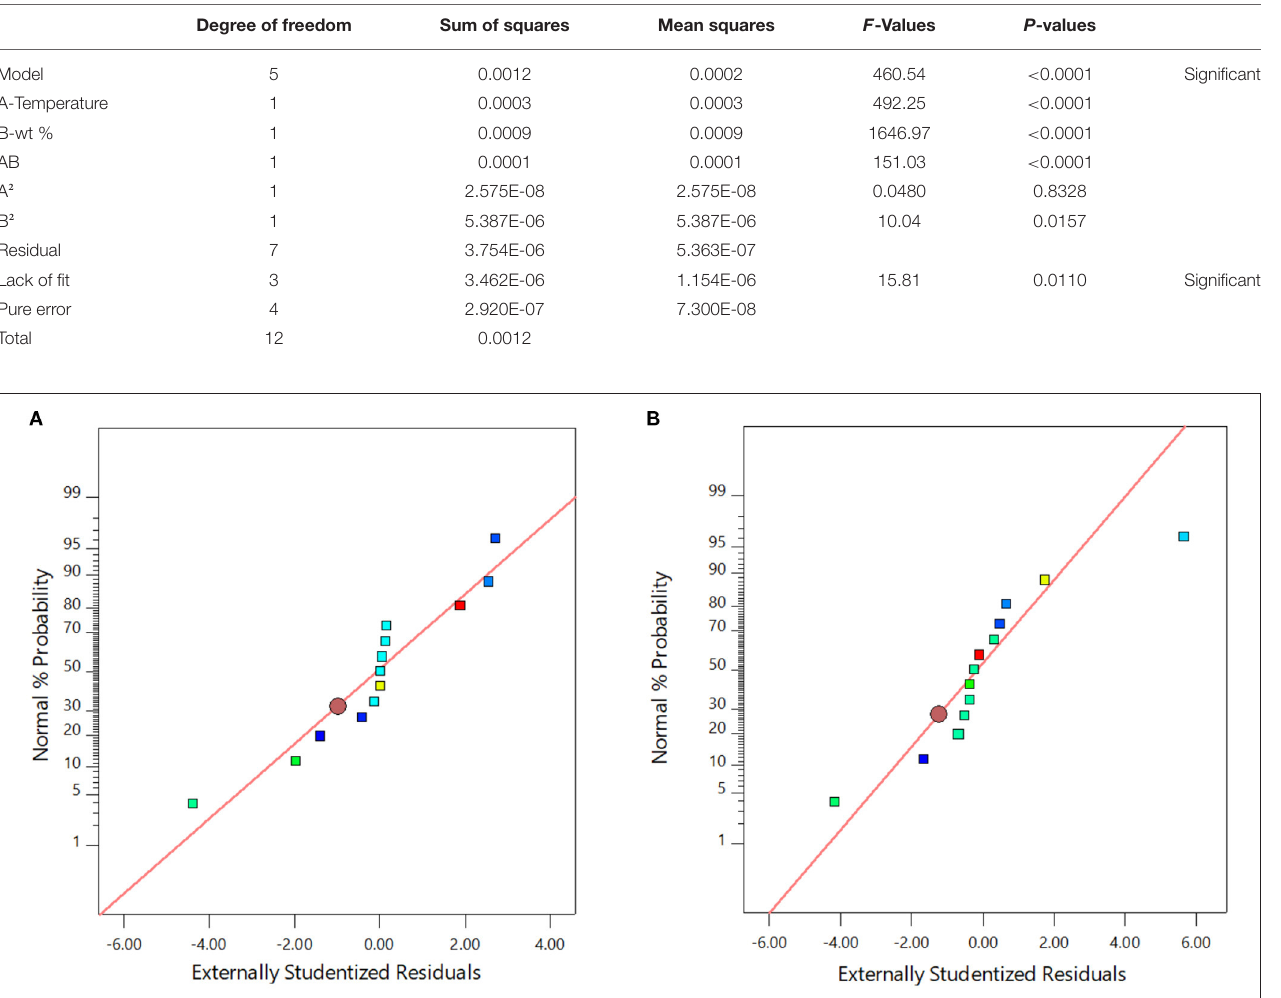
FIGURE 1 | Normal % probability plots for (A) viscosity and (B) thermal conductivity.